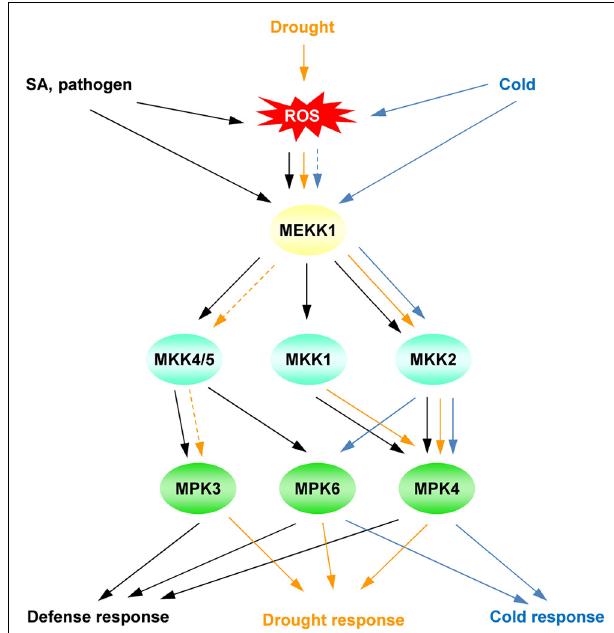
FIGURE 3 | Simplified model of the MAP kinase cascade, mainly focusing on MPK3/4/6. The different cascades are distinguished by different colors in the scheme. Solid lines indicate established signaling pathways; dashed lines indicate putative signaling